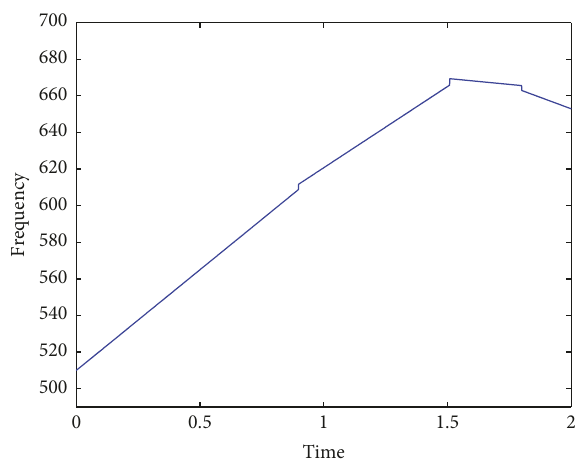
Figure 14: Estimated instantaneous frequency of the signal pre- sented in Figure 17.